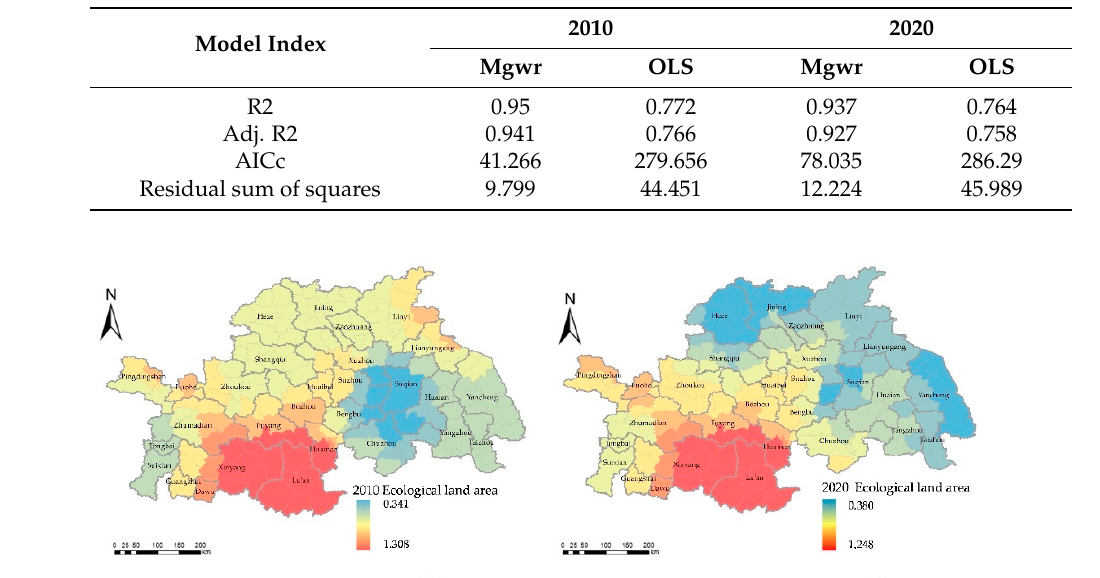
Figure 8. Distribution of regression coefficients of factors that affect the Huai River Basin SDI be- tween 2010 and 2020. Table 4. Parameter comparison of model running results.